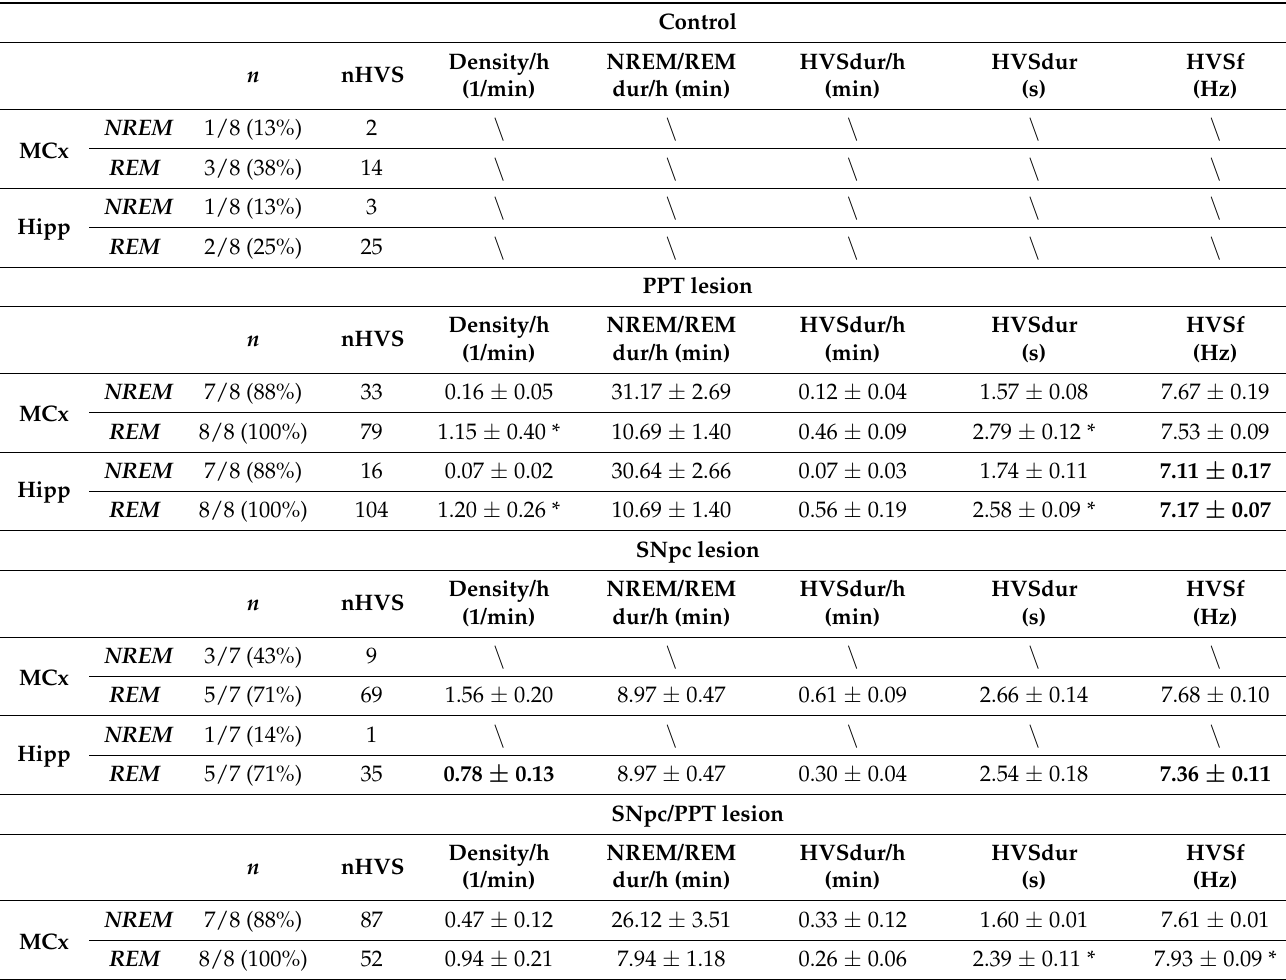
Table 2. High voltage sleep spindles (HVS) dynamic during NREM and REM sleep in the distinct rat models of